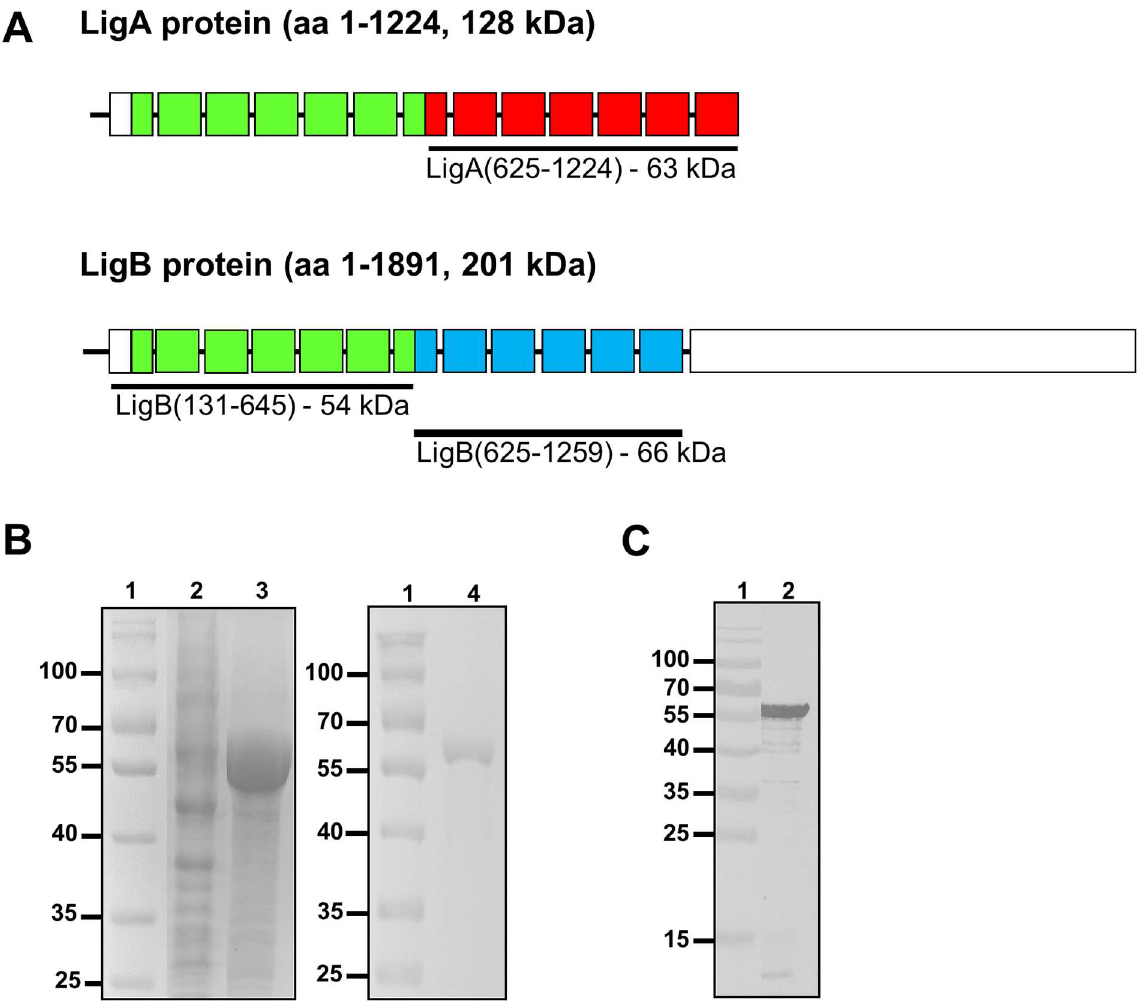
Fig 1. Schematic of the Lig proteins, expression and purification of rLigB(131–645). A) The full lengthamino acid sequences for LigA (1224 amino acids, 128.1 kDa) and LigB (1890 amino acids, 200.8 kDa) are indicated(black line), the square boxes indicate the BIDs and the LigB C-terminal domain is shown (rectangle). The recombinant proteins used as vaccine candidates are indicated: LigB(131–645) (green boxes) includesamino acids 131–645(53.5 kDa) and is highly identical(97.9% pairwiseidentity) to the same regionin LigA; the LigA(631–1224), also known as LigANI, (red boxes, amino acids 631–1224,62.8 kDa) and LigB(625–1259), also known as LigBNI, (blues boxes, amino acids 625–1259,66.2 kDa) fragments are not highly conserved(38.1% pairwiseidentity). B) Expression and purification of rLigB(131–645) analysedby 10% SDS-PAGE and Coomassie staining.Lanes 1: molecularmass marker (kDa); Expression of rLigB(131–645) in an E . coli (pLigB(131–645)) clone, lane 2: supernatant (soluble)fraction and lane 3: insoluble fraction; lane 4: IMAC purifiedrLigB(131–645), expectedmolecularmass of 57.2 kDa. C) Immunoblot analysisof rLigB (131–645), followingtransfer the nitrocellulosemembranewas probedwith an anti-His-HRP antibody,lane 1: molecularmass marker (kDa); lane 2: